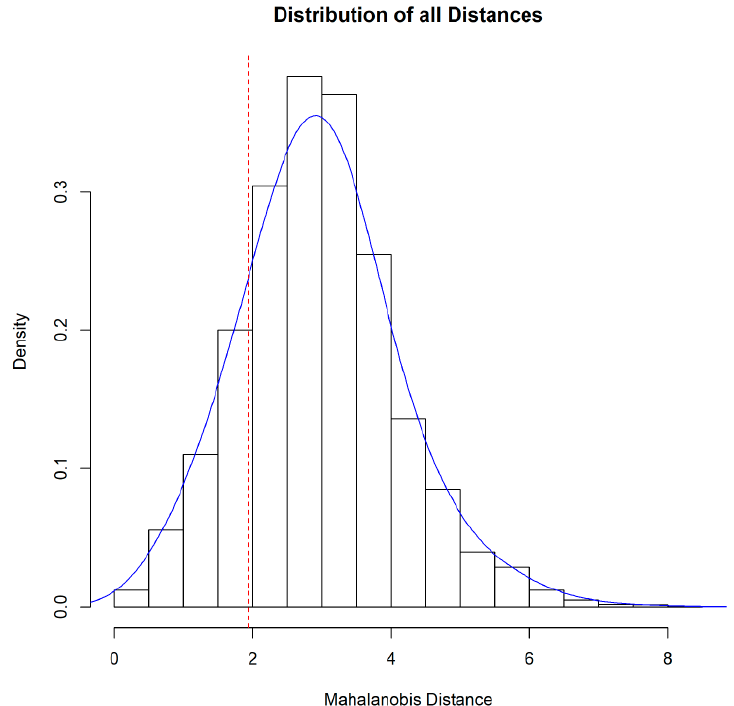
Figure 1. A histogram of the Mahalanobis distances of all NUTS2 regions against each other. The blue line is a fitted empirical (non-parametric) density function; the red line is at the maximum of the first derivative, i.e., a distance of 1.93.